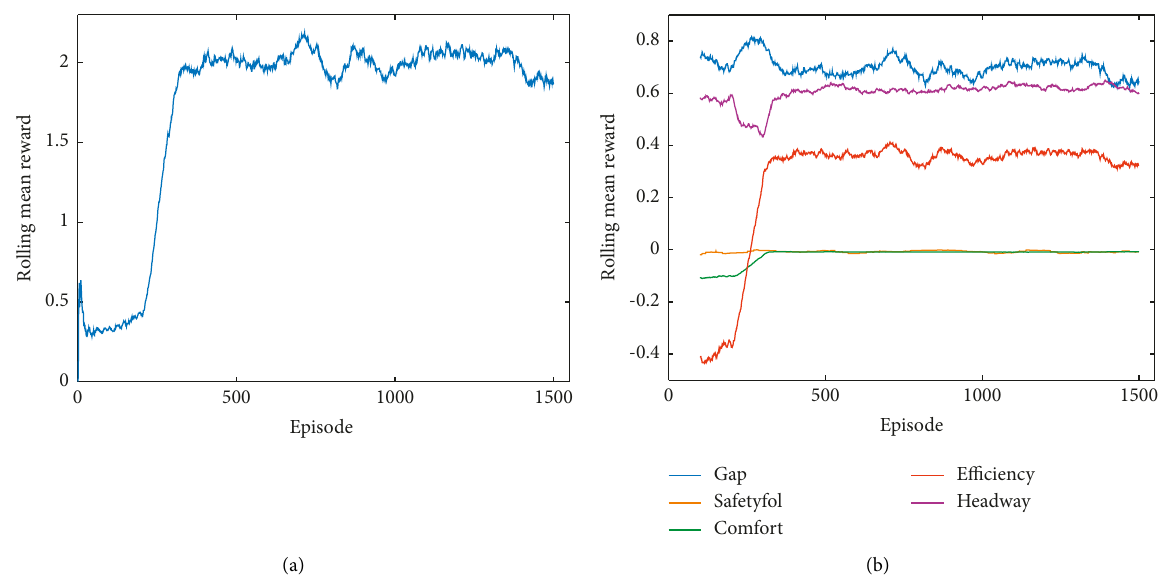
Figure 8: Rolling mean episode reward. (a) Total reward. (b) Each feature score.